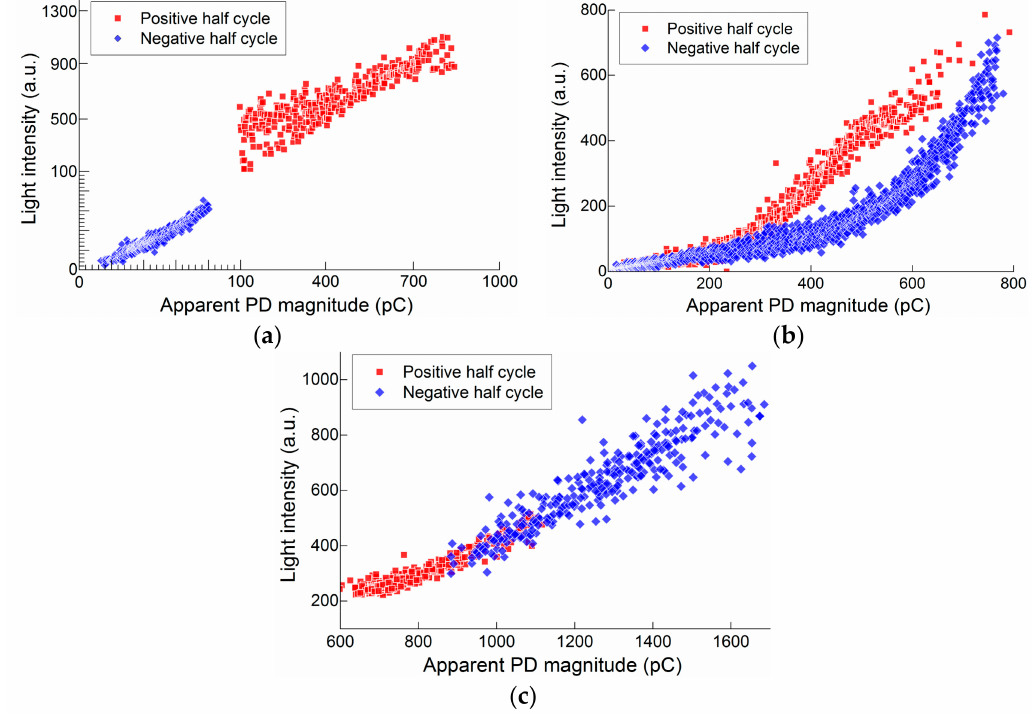
Figure 10. Light intensity detected by SiPM vs. apparent PD magnitude. ( a ) Point discharge; ( b ) Surface discharge; and, ( c ) Floating discharge. The tests are performed in air condition. Over-voltages applied on SiPM and PMT are 2.0 V and 600 V,